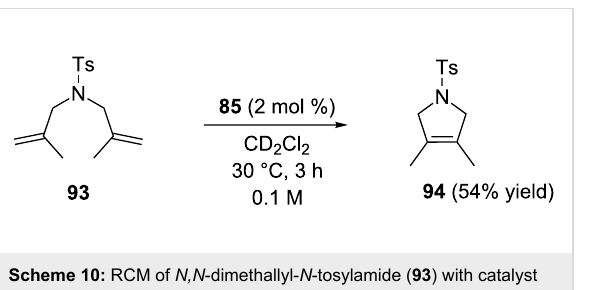
selectivity was observed with IndII-SIMes (Table 4, entries 3 and 4 ) and GII-SIMes (Table 4, entry 5), while IndII-IMes was inactive (Table 4, entry 6) and HGIIMes gave only low conversion (Table 4, entry